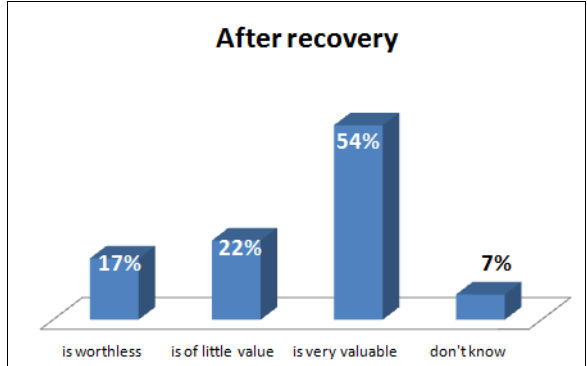
Figure 5. Survey on the attributed value to wash houses in population under fifty years after